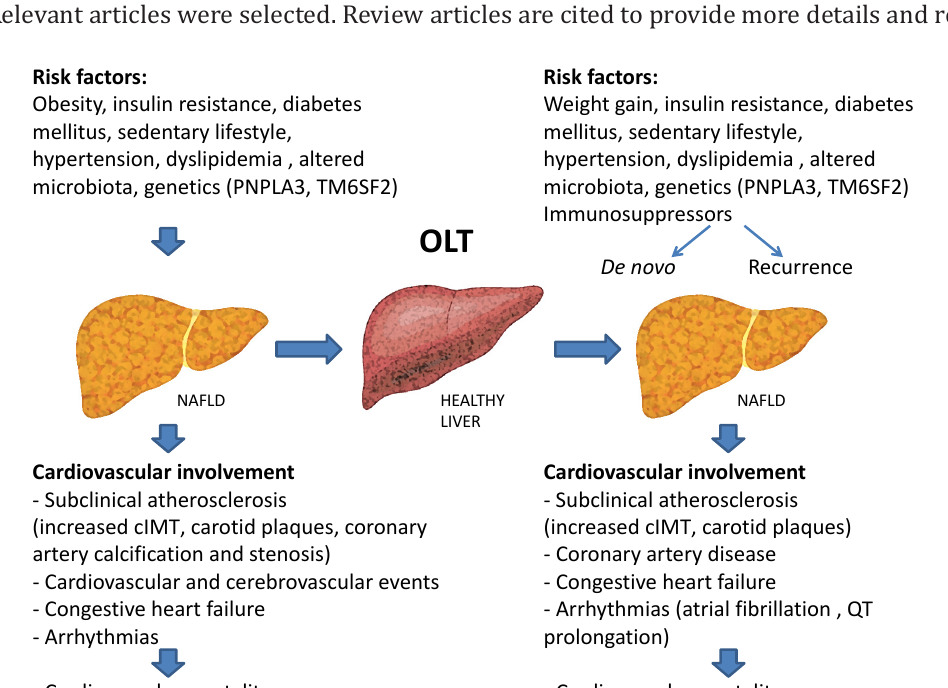
Figure 1 . Risk factors for the development of NAFLD and cardiovascular damage before and after liver transplantation. Obesity, insulin resistance, diabetes mellitus, hypertension, dyslipidemia, sedentary lifestyle, altered microbiota and genetics [patatin- like phospholipase domain containing 3 (PNPLA3) and transmembrane 6 superfamily member 2 (TM6SF2)] favor the onset